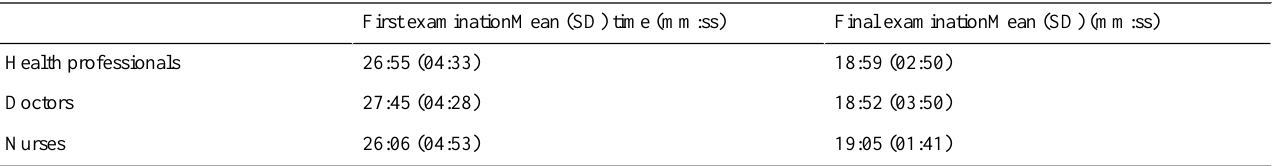
Final examinationMean (SD) (mm:ss)First examinationMean (SD) time